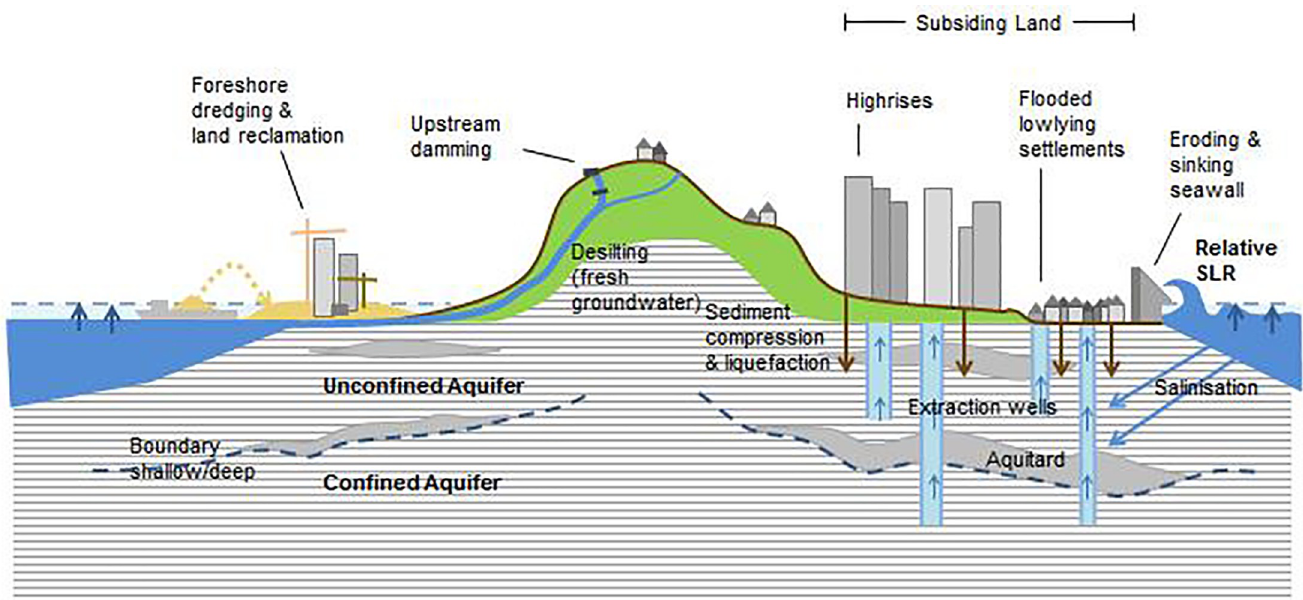
Fig 2. Conceptual illustration of anthropogenic and natural processes impacting LS in high-density coastal cities (source: Authors own).